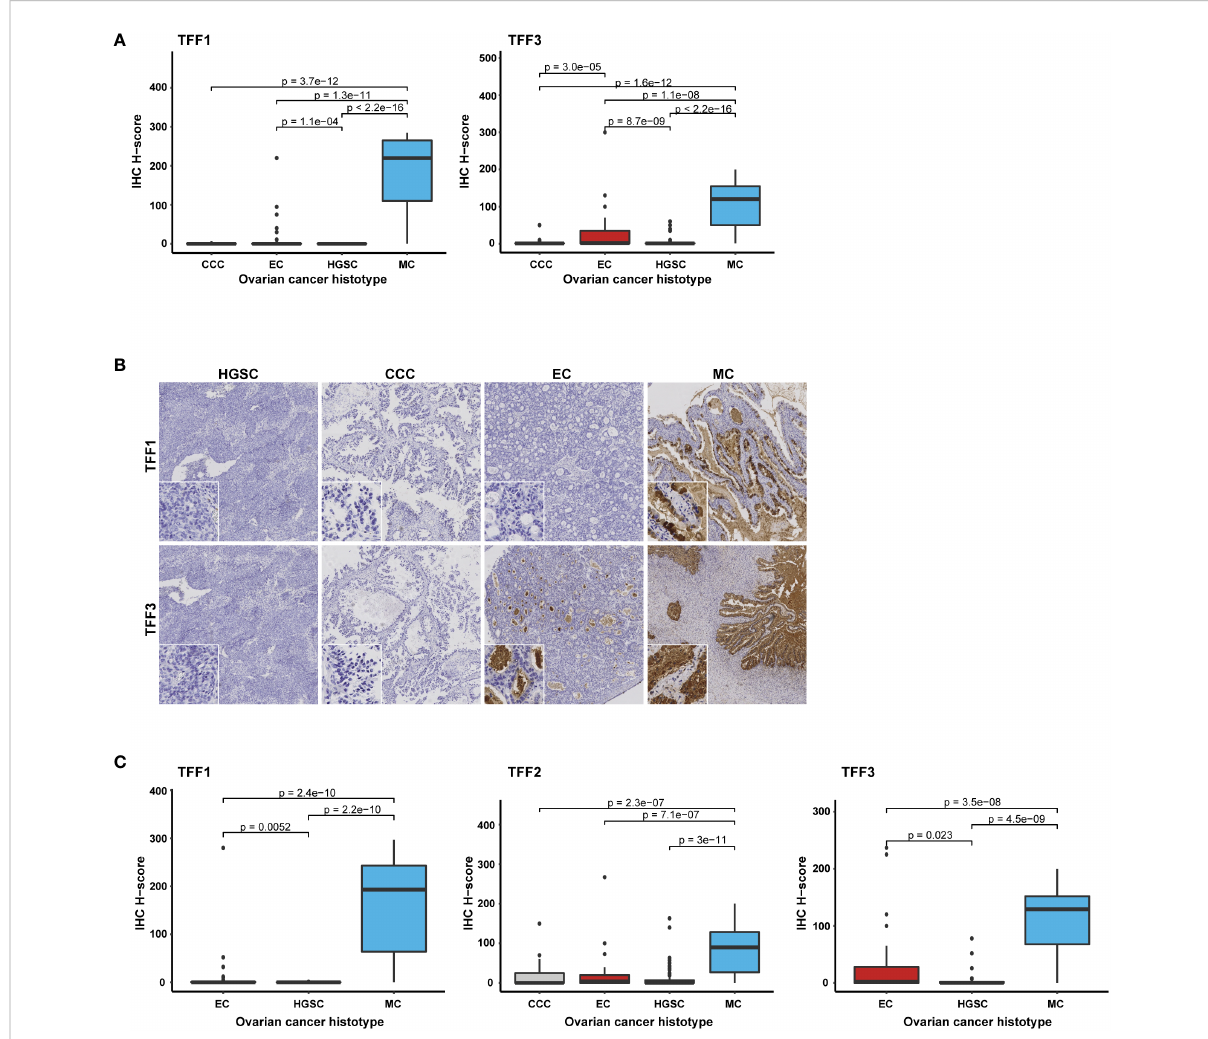
FIGURE 2 TFF1, TFF2, and TFF3 protein expression correlates with the MC histotype. Box plots illustrating protein expression in (A) full-face samples (n=206) for TFF1 and TFF3, (B) Immunohistochemical staining of TFF1 and TFF3 respectively presented in the different histotypes (to note the intraluminal secret sometimes was diffusely stained [TFF3], but left tumor cellular compartment negative), and (C) all three proteins (TFF1-TFF3) in TMA samples (n=103 for TFF1, n=102 for TFF3, and n=204 for TFF2) with the Kruskal-Wallis test and Benjamini-Hochberg adjusted p-values. CCC, Clear cell carcinoma; EC, Endometroid carcinoma; HGSC, High-grade serous carcinoma; and MC, mucinous